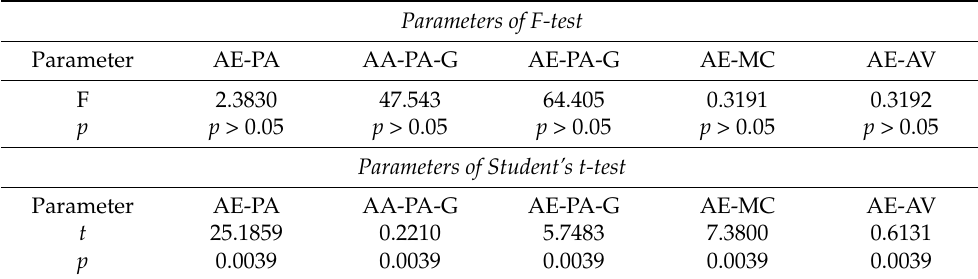
Table 5. Parameters of F-test and Student’s t